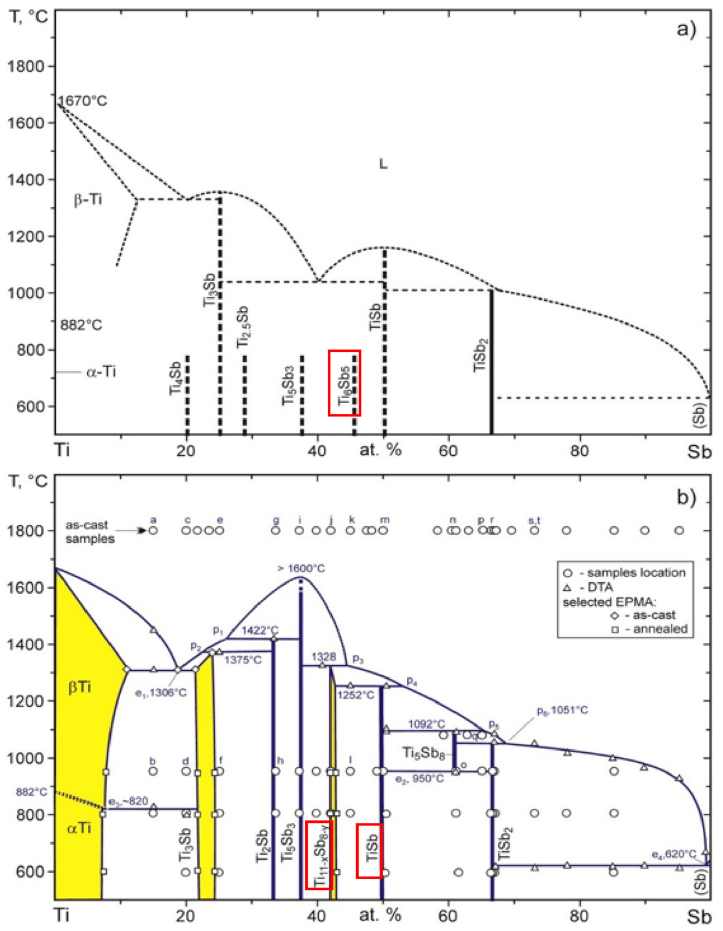
Figure 12 . Equilibrium diagram of titanium—antimony; ( a ) partial [40]; ( b ) completed [40]. Figure 12. Equilibrium diagram of titanium—antimony; ( a ) partial [40]; ( b ) completed